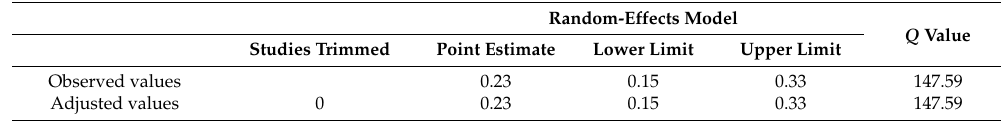
Table 8. Duval and Tweedie’s trim-and-fill analysis for alcohol consumption rate among truck-drivers based on the AUDIT-CAGE